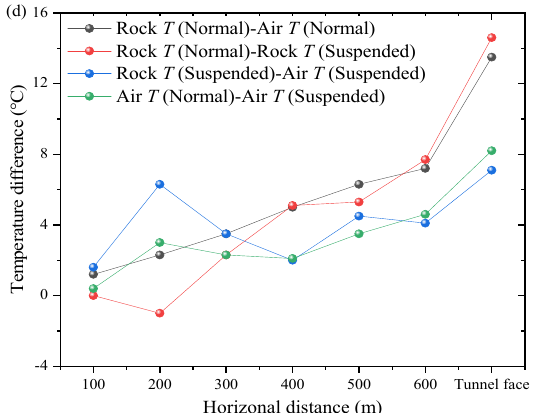
Figure 8. Variation curves of the air temperature and rock temperature with the horizontal distance under various construction conditions, in which T is the abbreviation of temperature: ( a ) Variation curves in the left tunnel; ( b ) variation curves in the right tunnel; ( c ) temperature difference in the left tunnel; ( d ) temperature difference in the right tunnel.